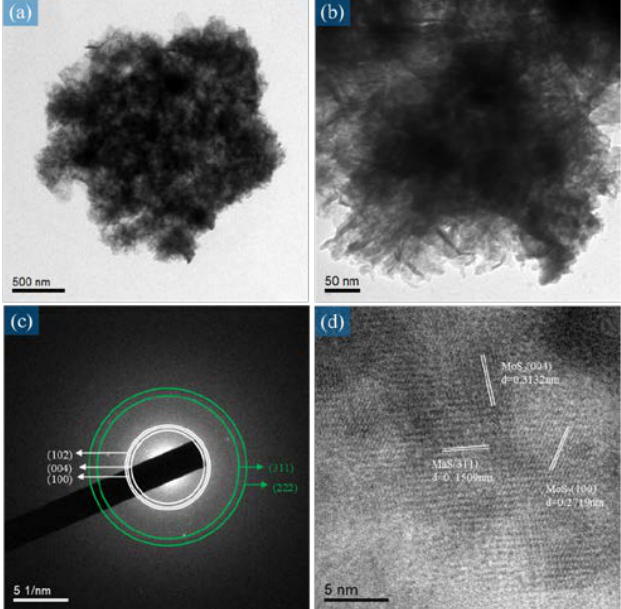
Figure 7. ( a , b ) TEM microscopic image analysis image of the MnS/MoS 2 composite film at different magnifications, ( c ) TEM selective diffraction image of the MnS/MoS 2 composite material, ( d ) TEM high solution image showing the lattice fringe of MnS/MoS 2 .